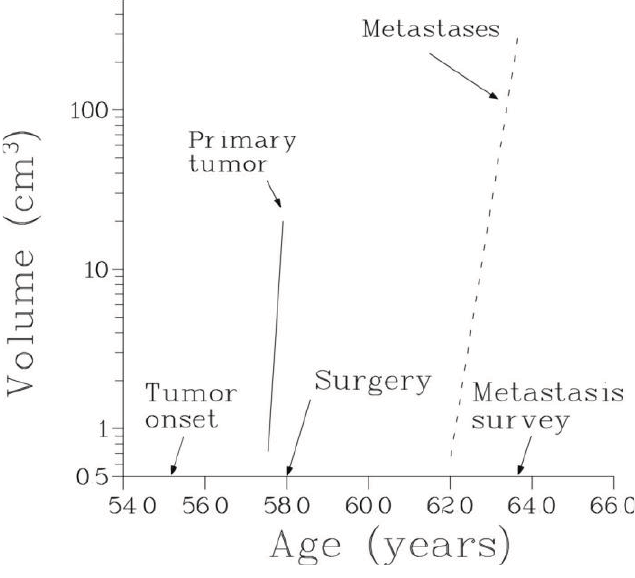
Figure 8. The volume of the primary tumor and the total volume of all detectable metastases represented as functions of age for patient 1. It is notable that as time progresses, the total metastatic volume by far exceeds the volume of the primary at the time of surgery. The total volume of metastases is dominated by the volume of the largest metastasis (that is, the metastasis with the earliest inception time, see also Figure